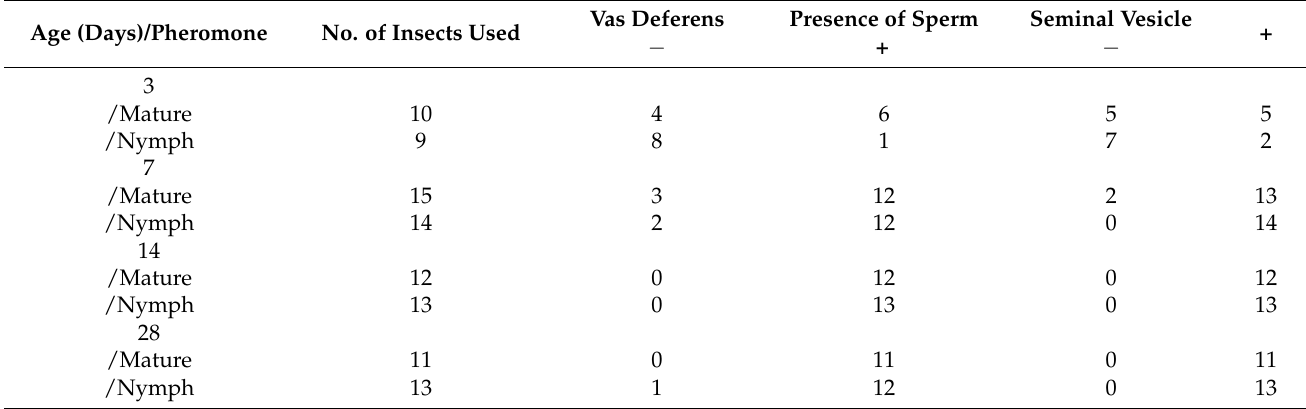
Table 5. Comparison of sperm distribution in the vas deferens and seminal vesicle between adult males that received the pheromone from mature adult males (Mature) and those from nymphs (Nymph) in the desert locust Schistocerca gregaria . Age (Days)/Pheromone